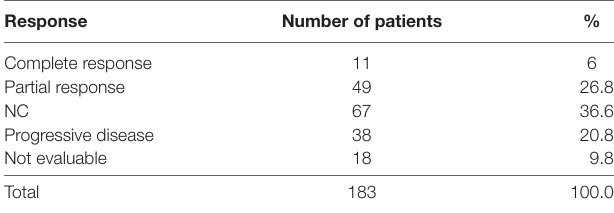
TaBlE 3 | Best response: WHO